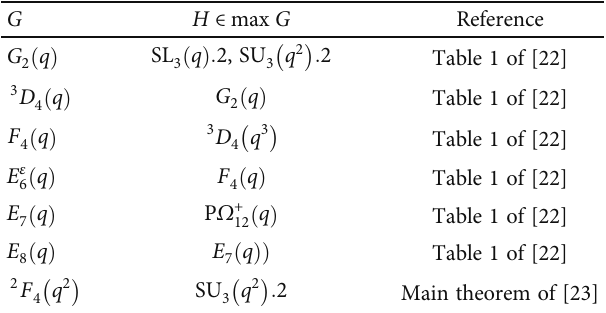
Table 2: Exceptional groups of Lie